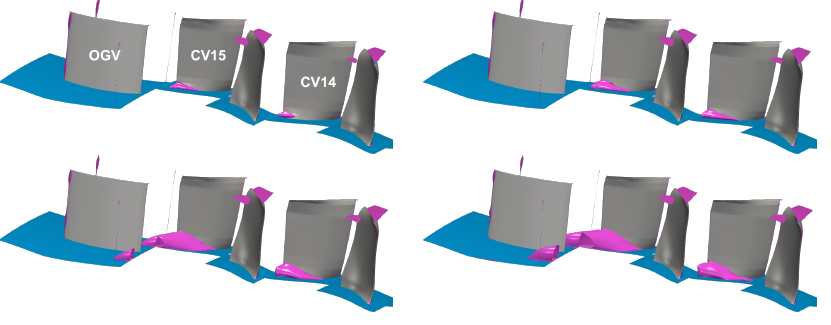
Figure 13. Recirculation flow regions highlighted by iso-surface of zero axial velocity for the 15C MEL IX BO operating